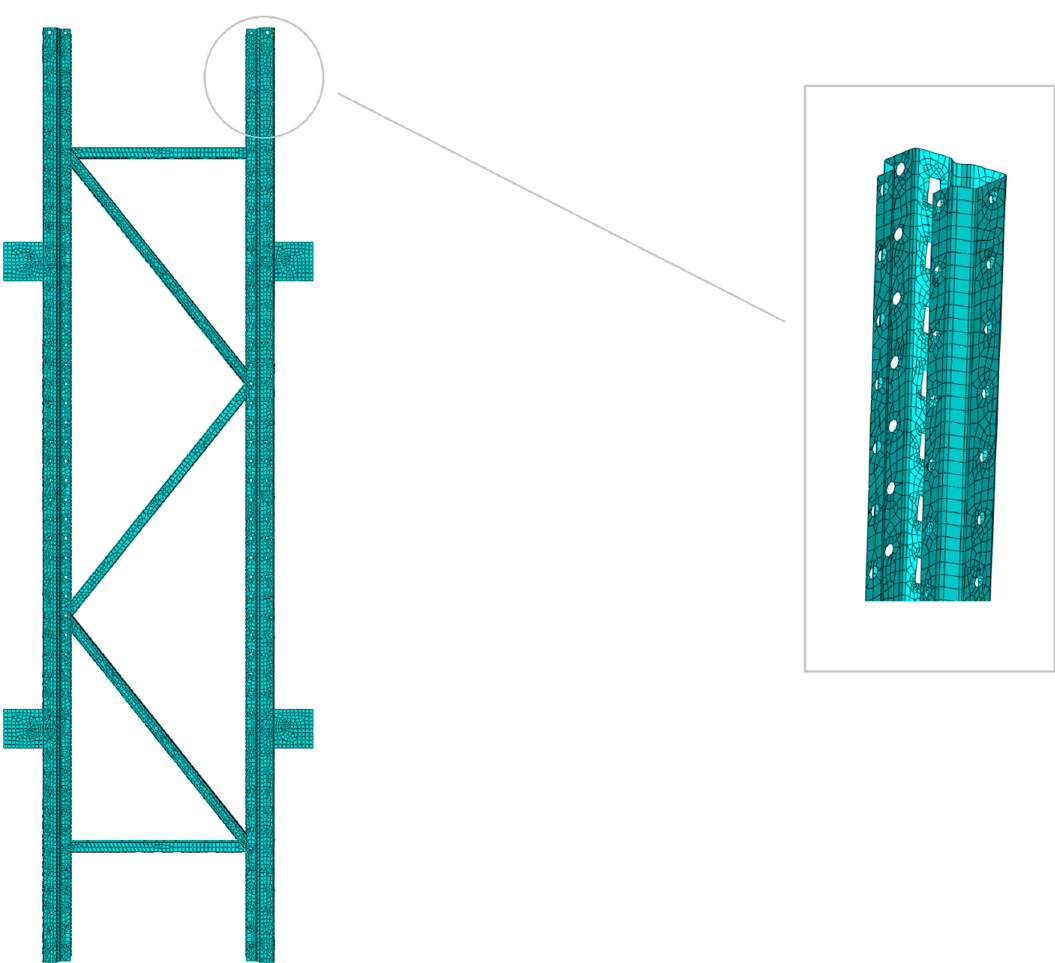
Figure 23. Typical finite element mesh of an upright section.